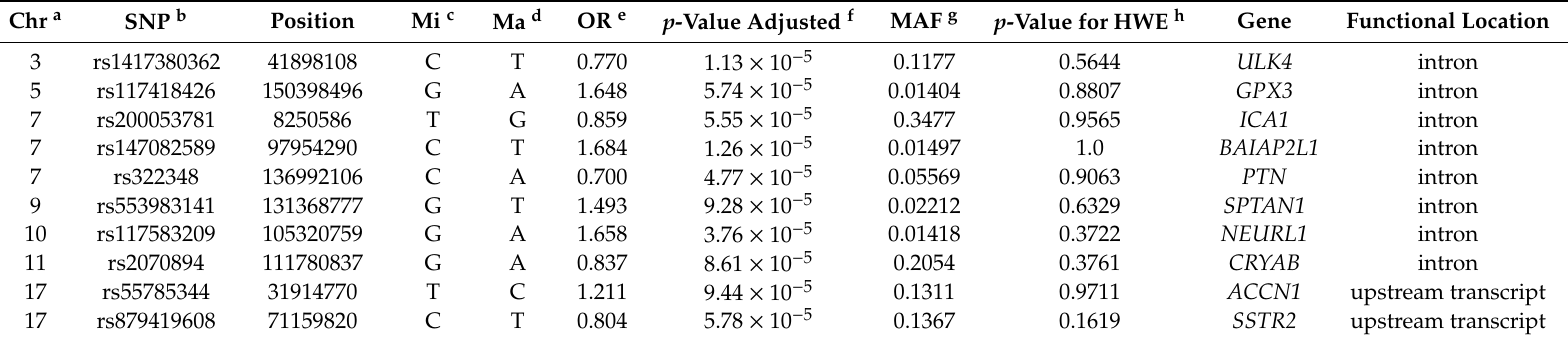
Table 2. The characteristics of the ten genetic variants of genes related to crystallin protein production, degradation, and aggregation in age-related cataract risk used for the generalized multifactor dimensionality reduction